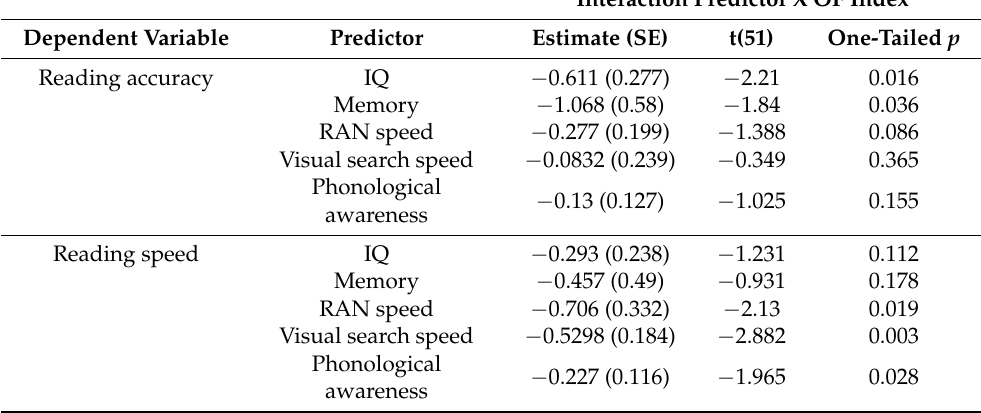
Table 1. Interactions between specific predictors and OF index (the other factors combined) on reading